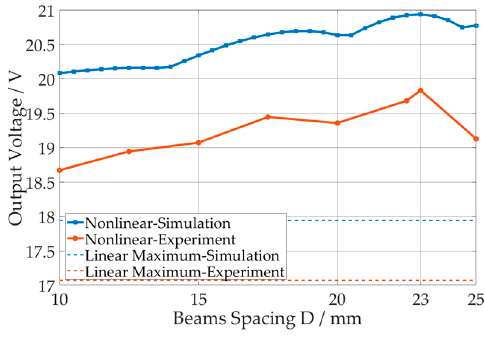
Figure 9. Output voltage at different D with B r = 0.12 T based on simulation and experiment.